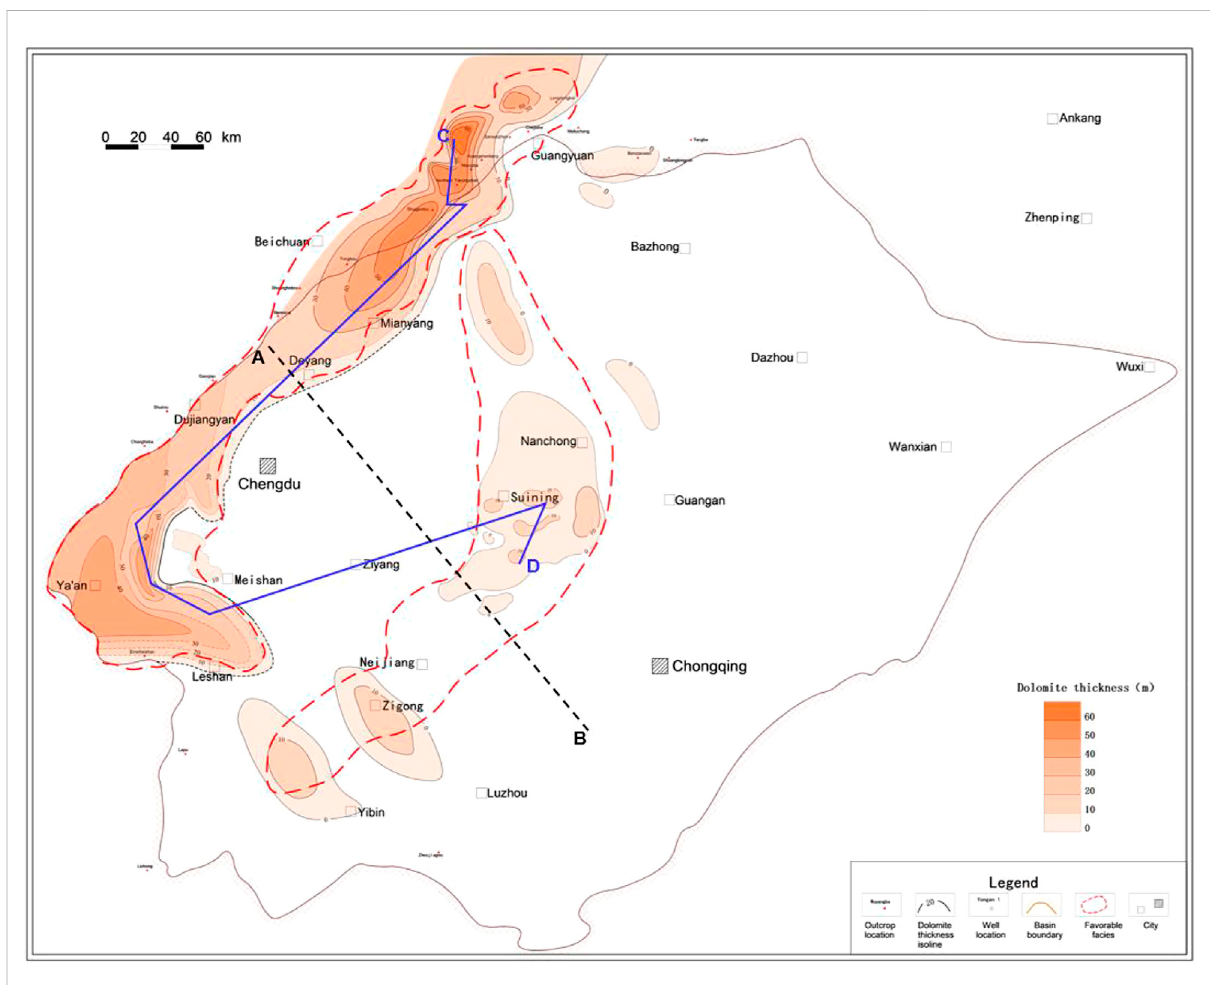
FIGURE 3 Contour mapshowingthethicknessofdolomitesintheQixiaFormation,SichuanBasin.PanelsAandBshowthelocationofFigure9andCand D show the location of Figure